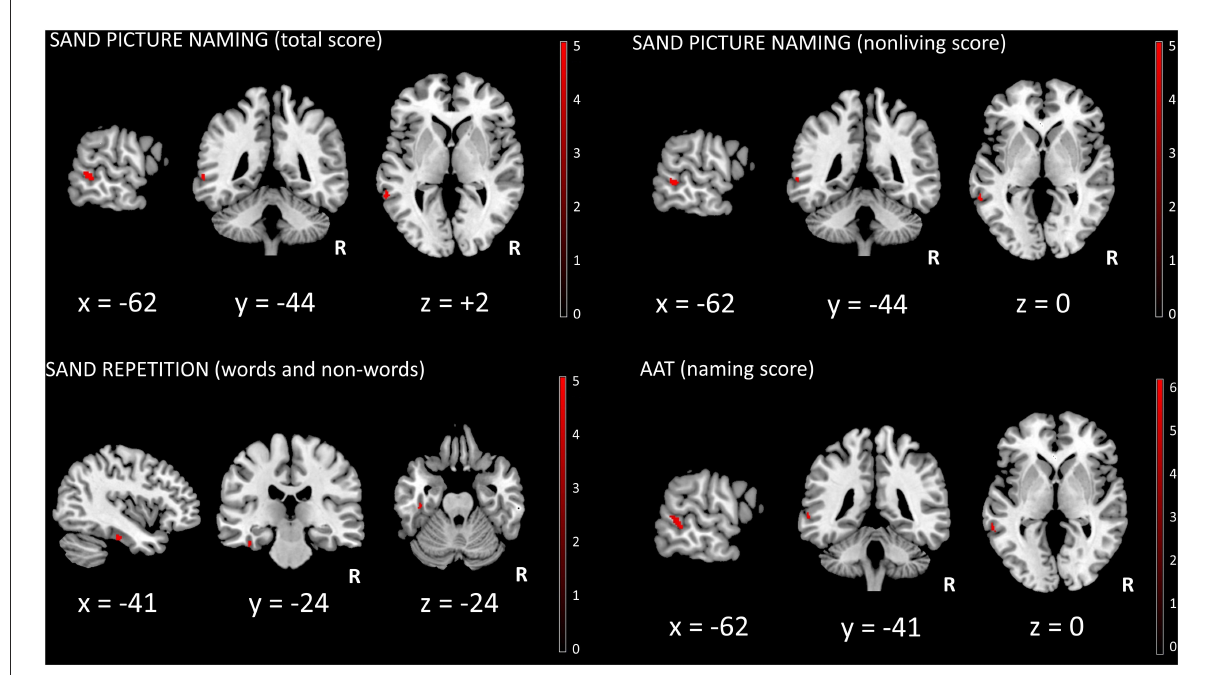
FIGURE1 SPM univariate analysis. Significant clusters (surviving FWE whole-brain correction, p < 0.05) were superimposed on a standardized T1 MRI template (MRIcron, https://www.nitrc.org/projects/mricron). R, right; SAND, Screening for Aphasia in NeuroDegeneration battery; AAT, Aachener Aphasie